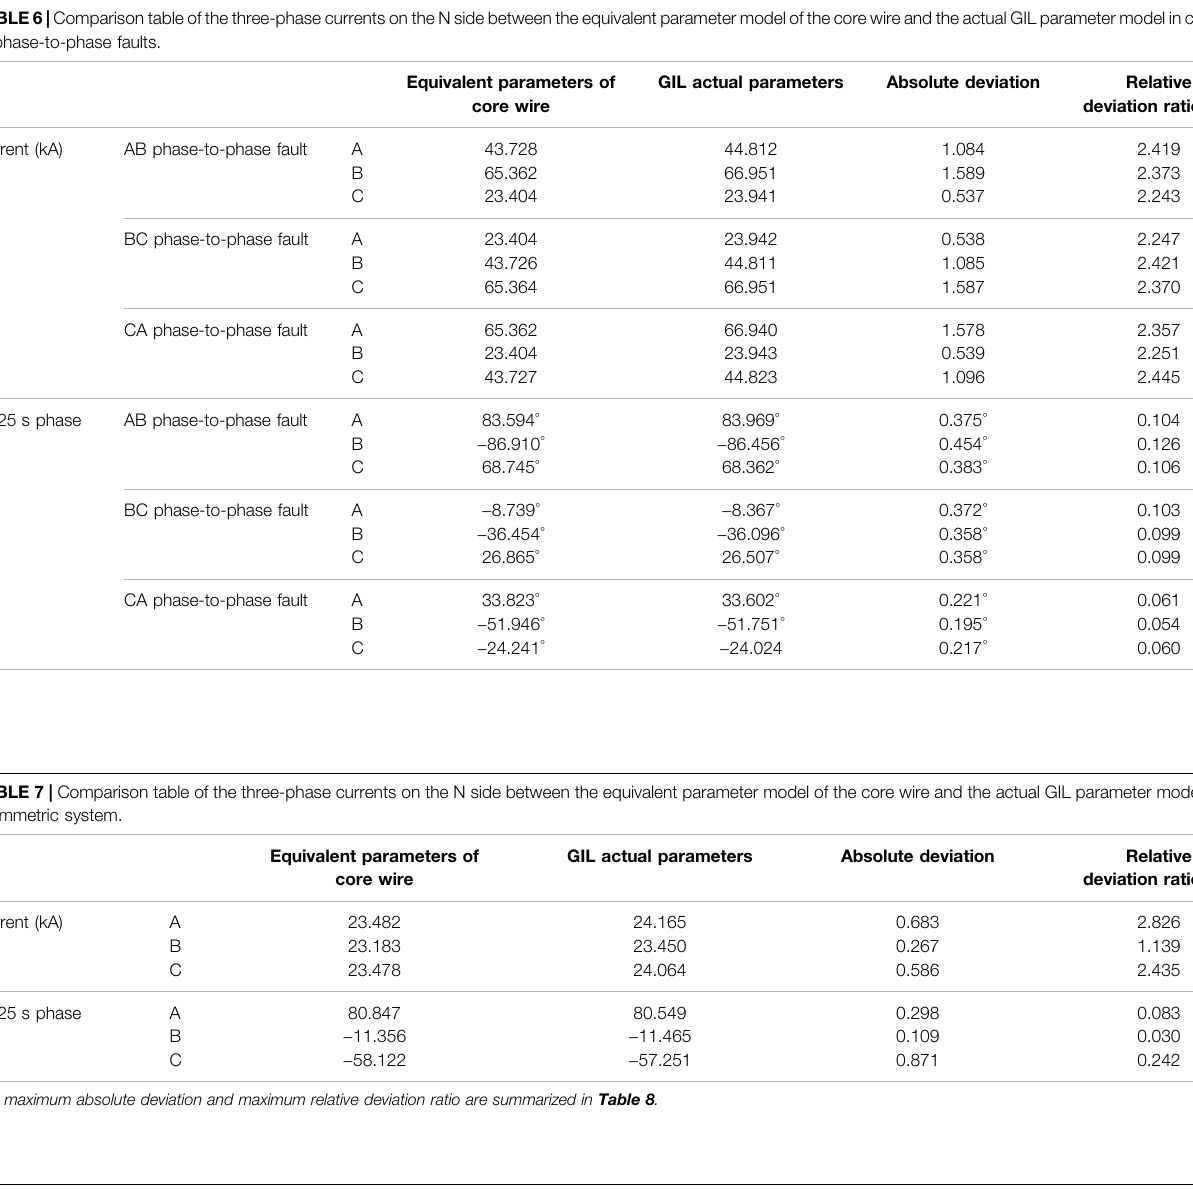
TABLE 8 | Maximum absolute deviation and relative deviation ratio in different